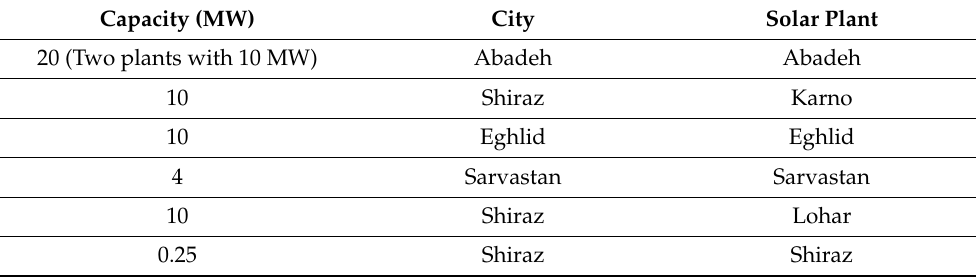
Table 3. Solar power plants of Fars province. Capacity (MW) City Solar